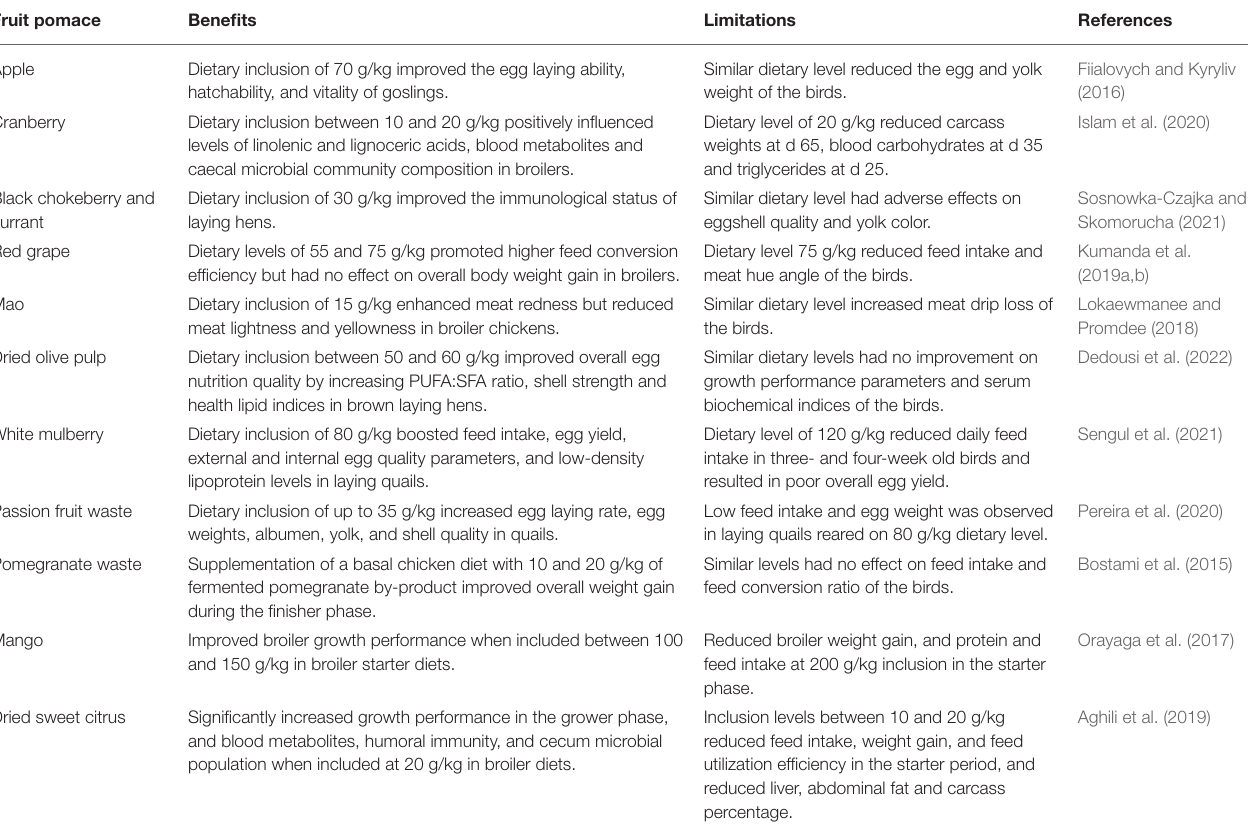
TABLE 1 | Effect of incorporating various fruit wastes in poultry diets. Fruit